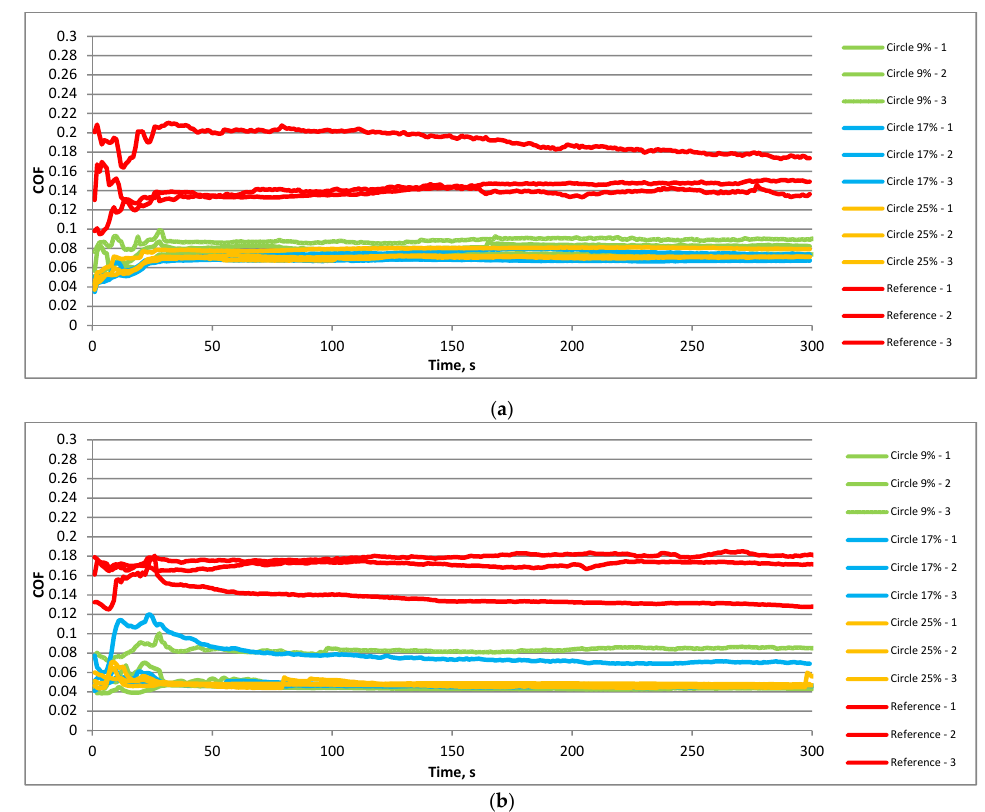
Figure 7. Courses of the coefficient of friction under the following operating conditions: f = 40 Hz; F = 40 N; T = 30 °C ( a ) and f =40 Hz; F = 80 N; T = 30 °C ( b ). The analysis of runs of the coefficient of friction in one stroke led us to similar findings. In both cases shown in Figure 8, the highest coefficients of friction were obtained for untextured samples. A decrease in temperature caused lower values of the friction coefficient, especially of textured assemblies. Among them, the highest coefficient of friction was obtained for the smallest pit/area ratio of disc samples. The graphs shown in Figure 8 were obtained after stabilizations of the friction coefficients. The exact time of data extraction was 4 min 50 s after the start of the selected subtest.